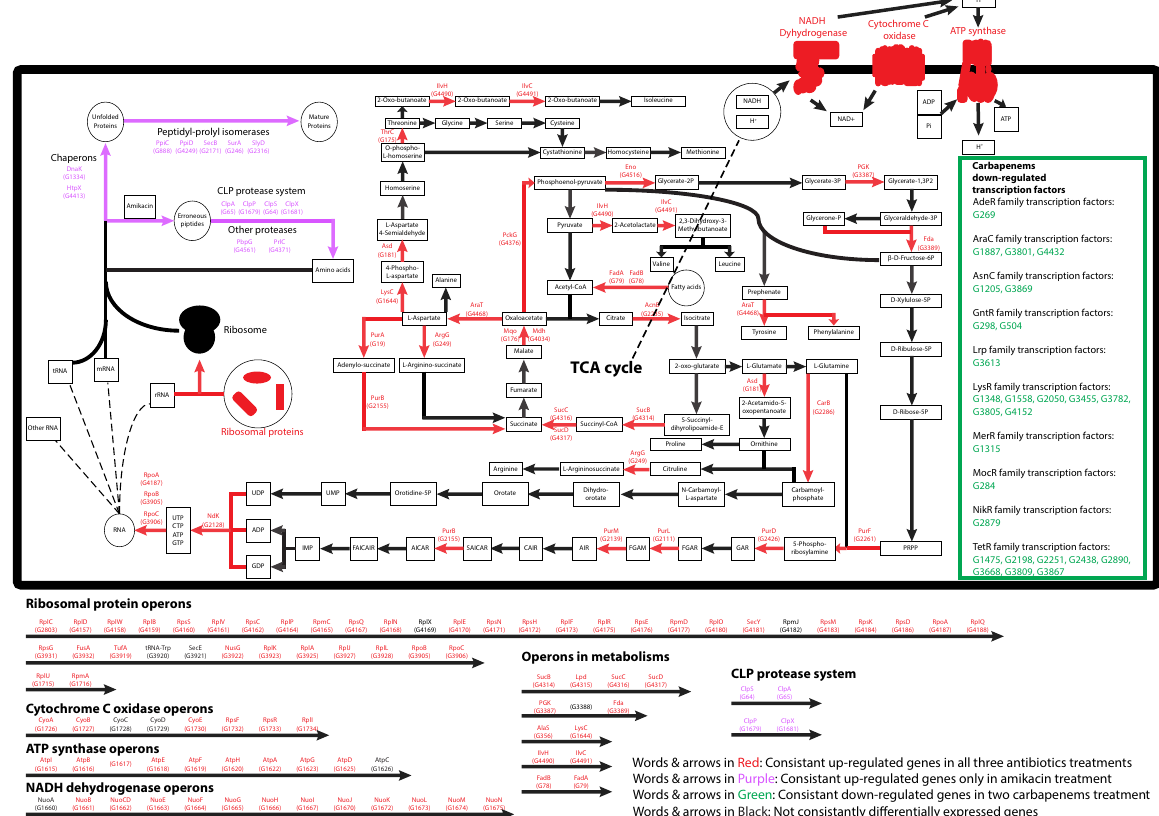
Words & arrows in Red: Consistant up-regulated genes in all three antibiotics treatments Words & arrows in Purple: Consistant up-regulated genes only in amikacin treatment Words & arrows in Green: Consistant down-regulated genes in two carbapenems treatment Words & arrows in Black: Not consistantly differentially expressed genes Figure 2. Genes that were differentially expressed under antibiotic treatment. Red genes or arrows: genes that were consistently up-regulated under treatment with all three antibiotics. Purple genes or arrows: genes that were consistently up-regulated only under treatment with amikacin. Green genes or arrows: genes that were consistently down-regulated only under treatment with the two carbapenem-related